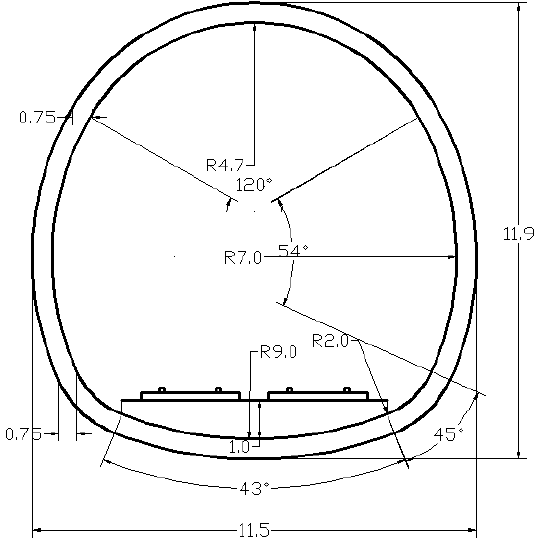
Figure 4. Dimensions of tunnel section (m).